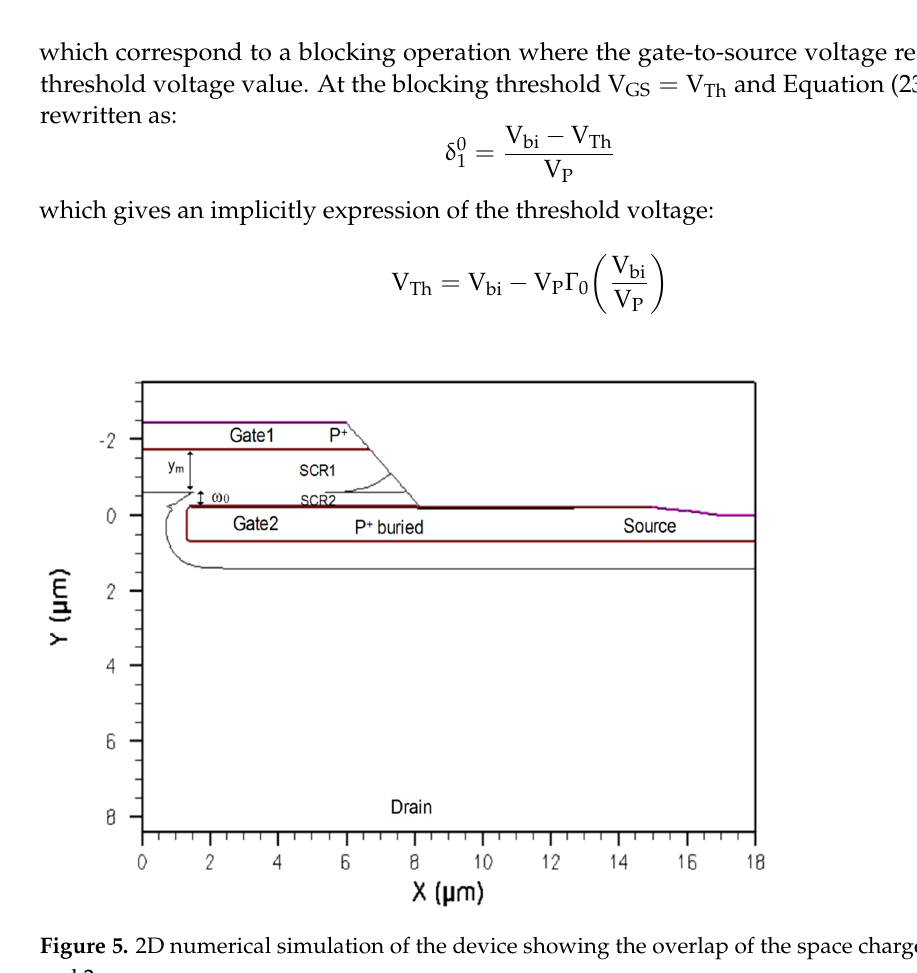
Figure 5. 2D numerical simulation of the device showing the overlap of the space charge regions 1 and 2.